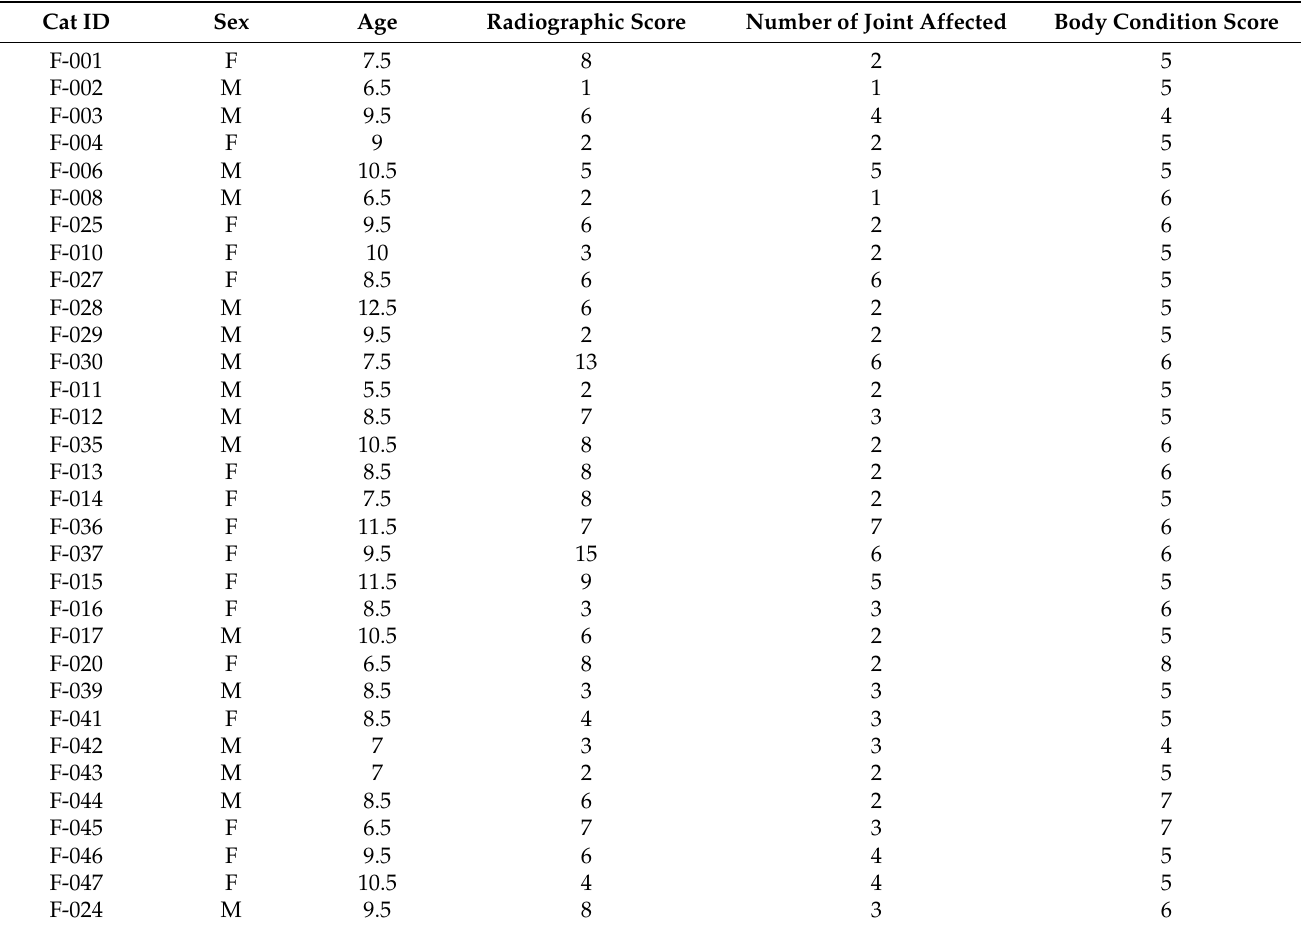
Table A1. Characteristics of the 32 cats included in the